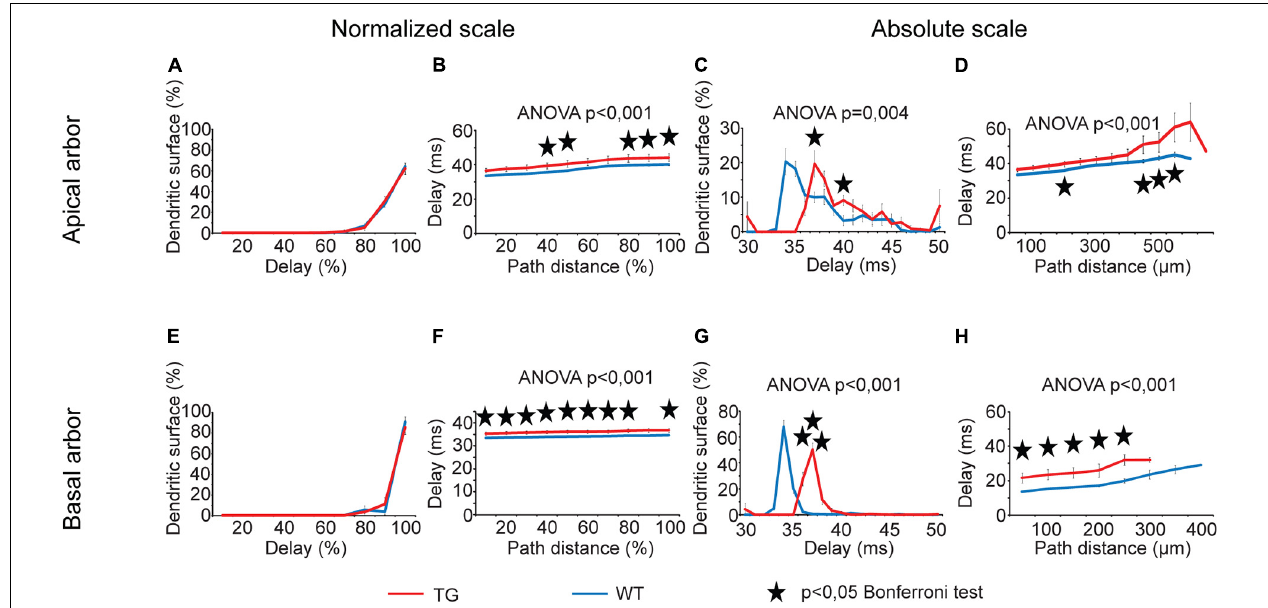
FIGURE 8 | Alterations in delays of PSPs in advanced tauopathy. See legend for analog Figure 5 with the difference that instead of transfers; here time delays of individually generated PSPs were graphed. For better visibility, distribution of dendritic surface area over absolute scale of delays is shown for the 30–50-ms interval only, where statistically significant alterations in TG neurons were detected. Outside this delay range, fractions of dendritic surface area quickly converge to zero in both TG and WT neurons. Overall statistical evaluations of comparison graphs were made by two-way ANOVA tests. Significance levels of these ANOVA tests were indicated where statistically significant overall alteration in comparison graphs was found (elsewhere p > 0.05). Asterisks mark path distance regions and transfer intervals with statistically significant differences between WT and TG neurons (Bonferroni post hoc test, p < 0.05). Distance regions and transfer intervals with less than 3–3 data points in TG-WT comparisons were omitted from statistical tests. TG and WT neurons are red and blue lines,